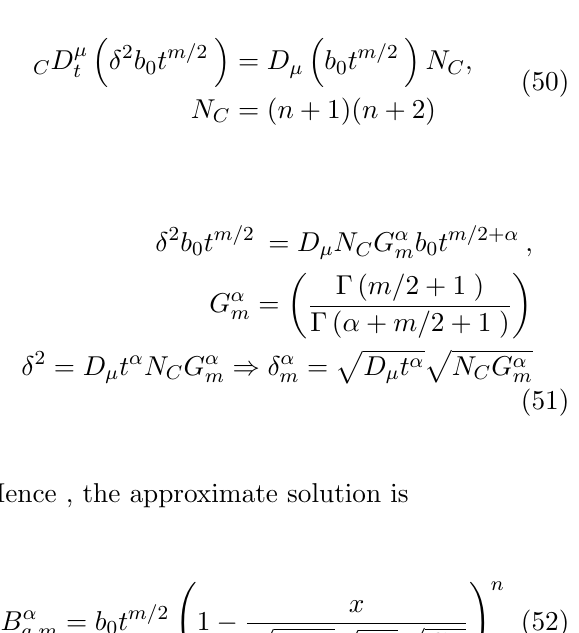
Figure 4. DIM solutions to the mag- netization of field-independent mate- rial with Dirichlet Boundary condi- tion, with : stipulated exponent of the parabolic profile n = 2 (a) and optimal exponent n opt = 2 . 248 (b), compared to exact